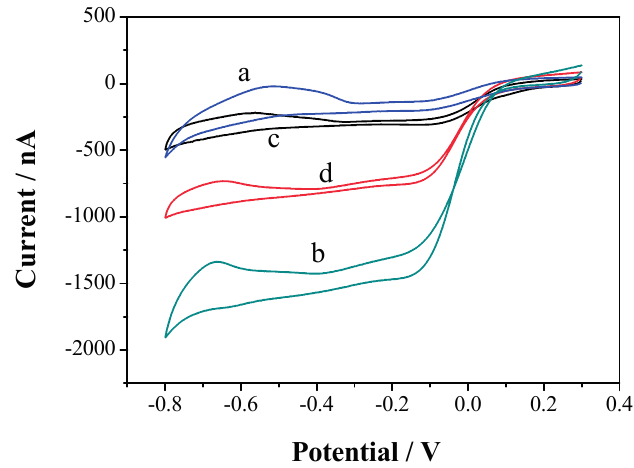
Figure 8. Response of PdNPs/rGN-COOH/UMEA in absence (a) and presence (b) of DO and PdNPs/UMEA in absence (c) and presence (d) of DO.